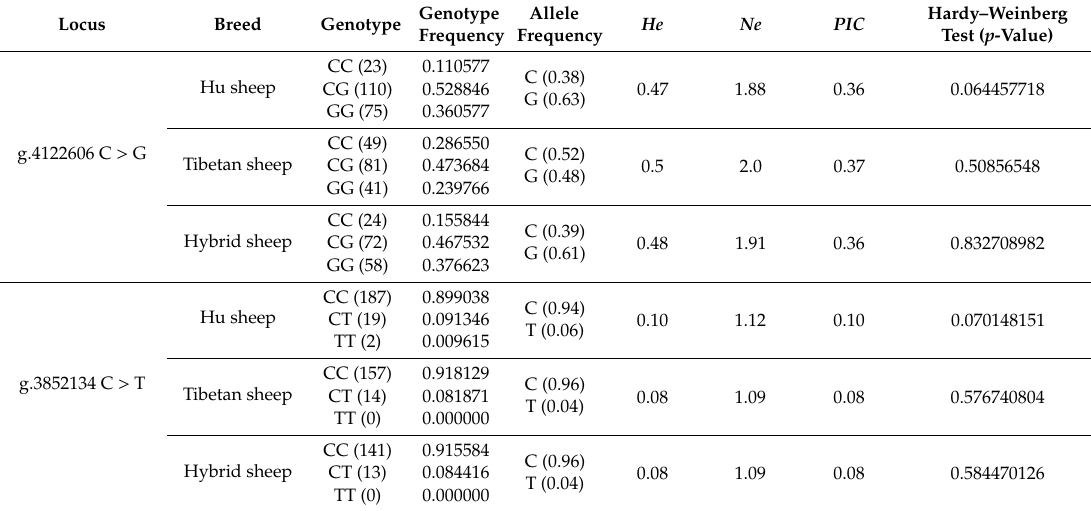
Table 1. Genetic parameter calculation of g.4122606 C > G and g.3852134 C > T. Locus